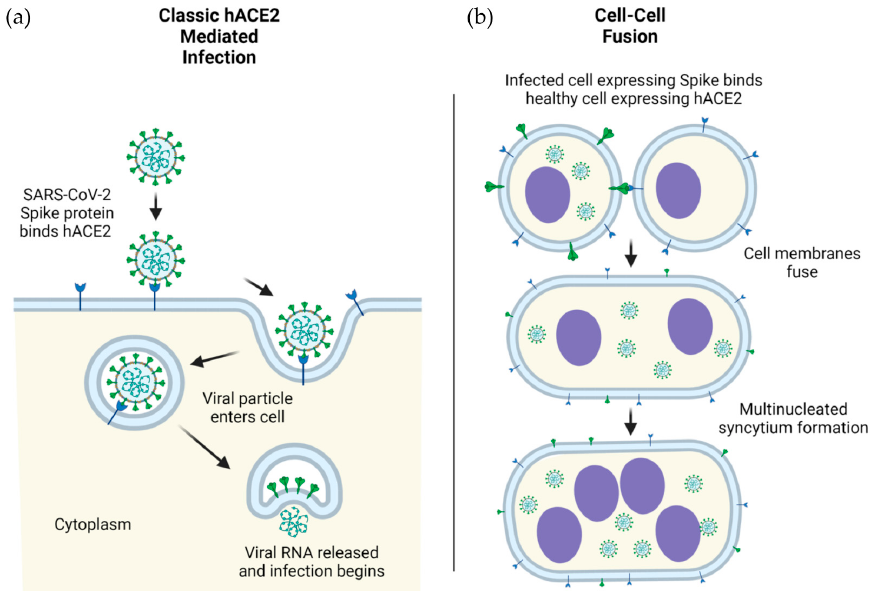
Figure 1. ACE2-mediated cellular infection by SARS-CoV-2. ( a ) Schematic of direct cellular entry of SARS-CoV-2 viral particles into human cells, mediated by ACE2. ( b ) Cellular infection by ACE2-spike mediated cell-cell fusion. Infection in human (h) cells is used as an example.